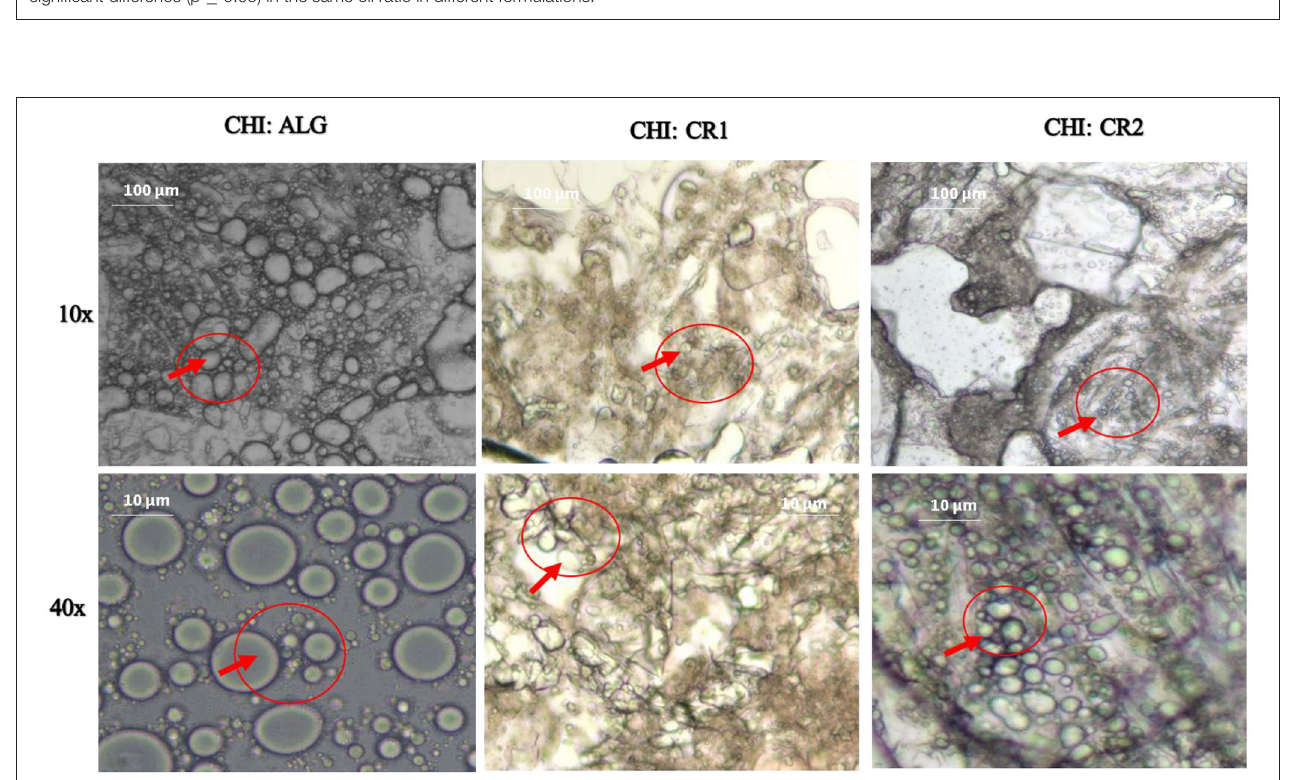
FIGURE 6 | Optical micrograph of CHI:ALG, CHI:CR1, and CHI:CR2 (polymer ratio